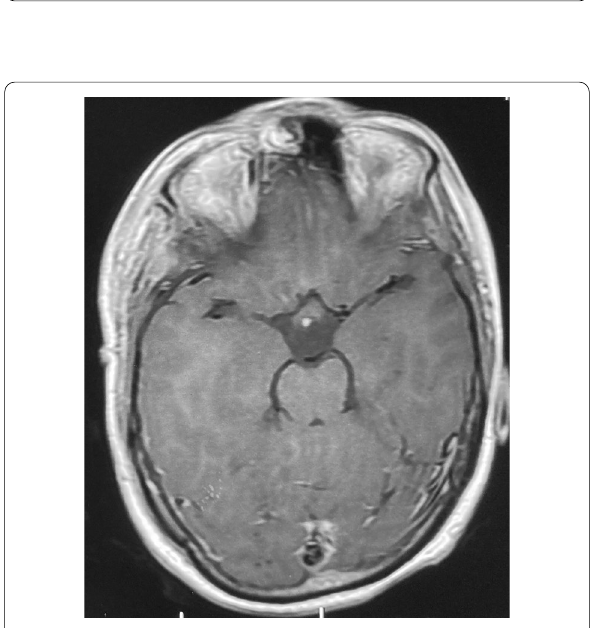
Fig. 10 Post-operative MRI axial section showing complete removal